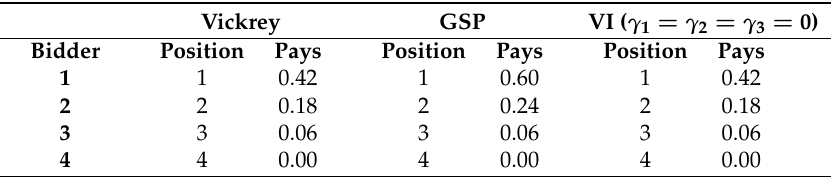
Table 1. Three positions and four